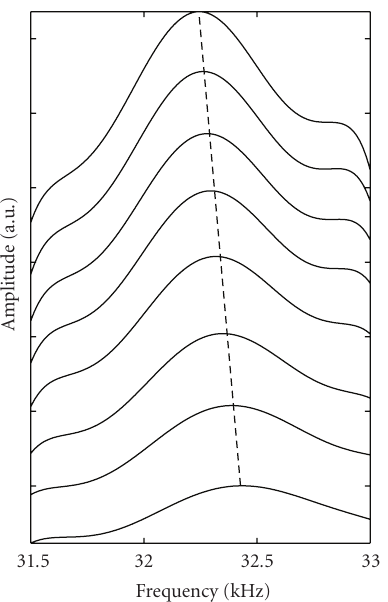
Figure 4: NRUS experiment for the 120 ◦ C damaged sample.